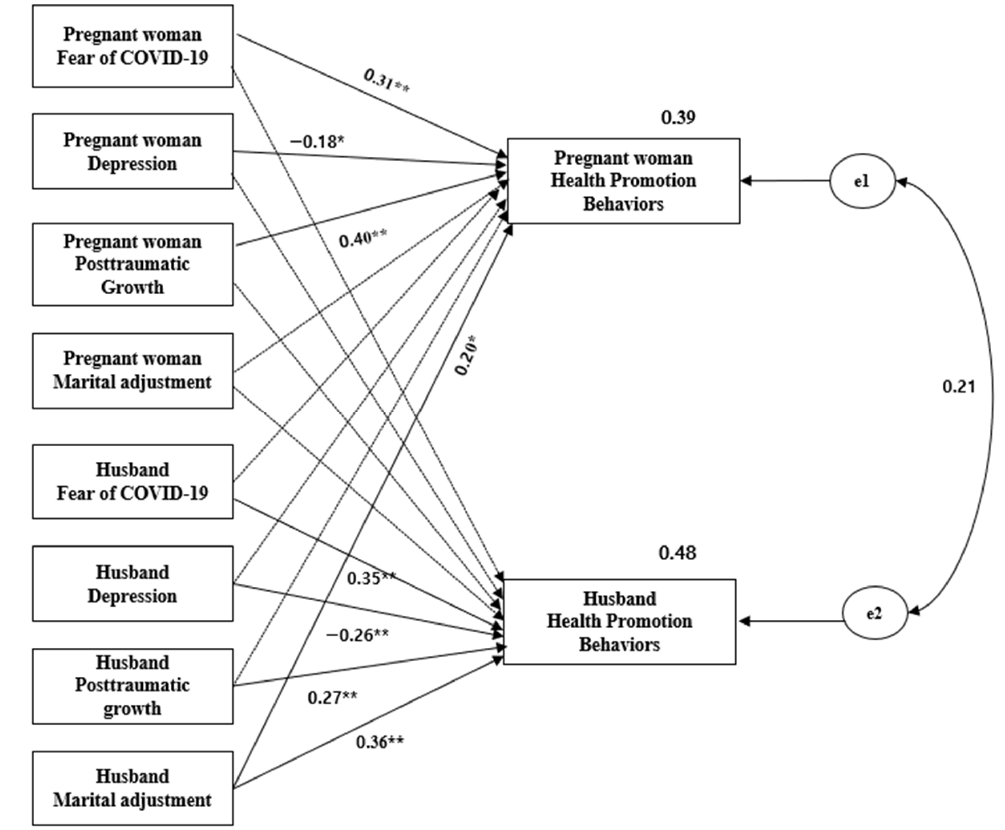
Figure 2. Actor and partner effects on health promotion behaviors. Note. * p < 0.05, ** p < 0.001; e1 and e2: measurement error variance.